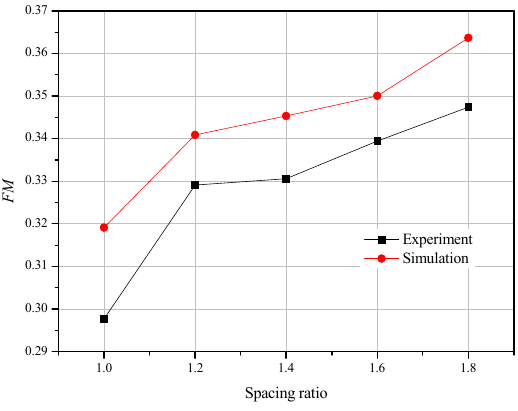
Figure 8. Comparison between experimental and simulation results.